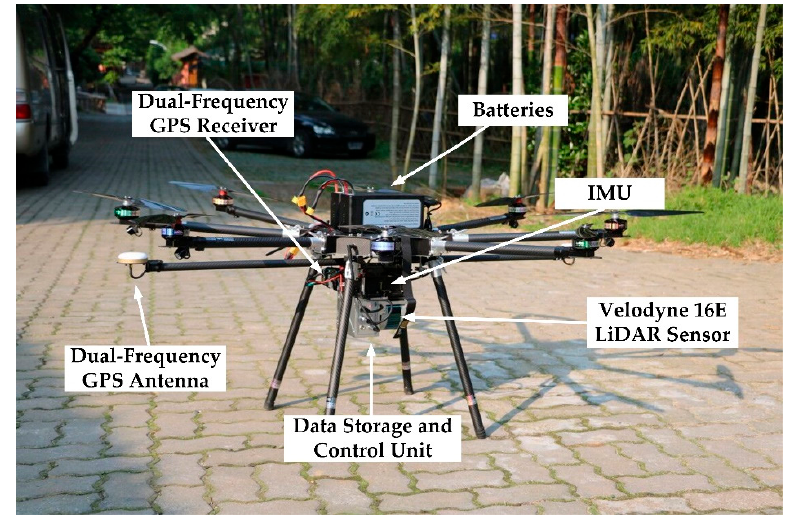
Figure 3. Main components of the UAV platform and Velodyne 16E laser scanner system.